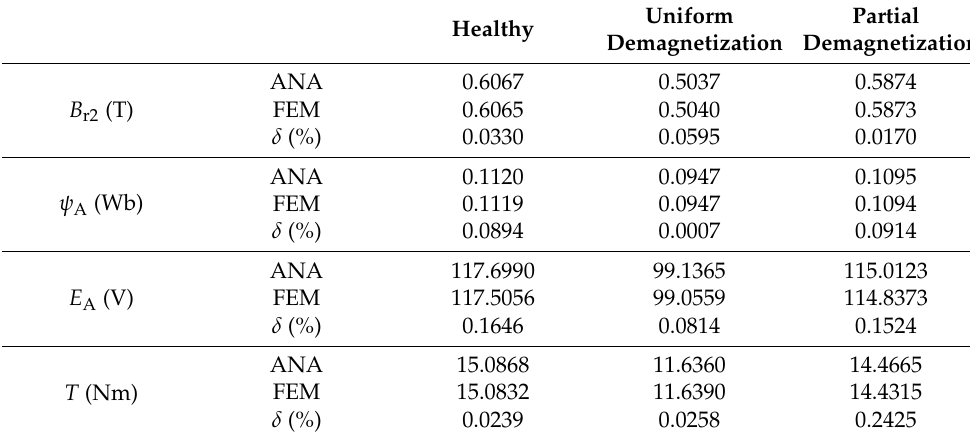
Table 3. Comparison of RMS and error for PM motor with radially magnetized PMs. Healthy